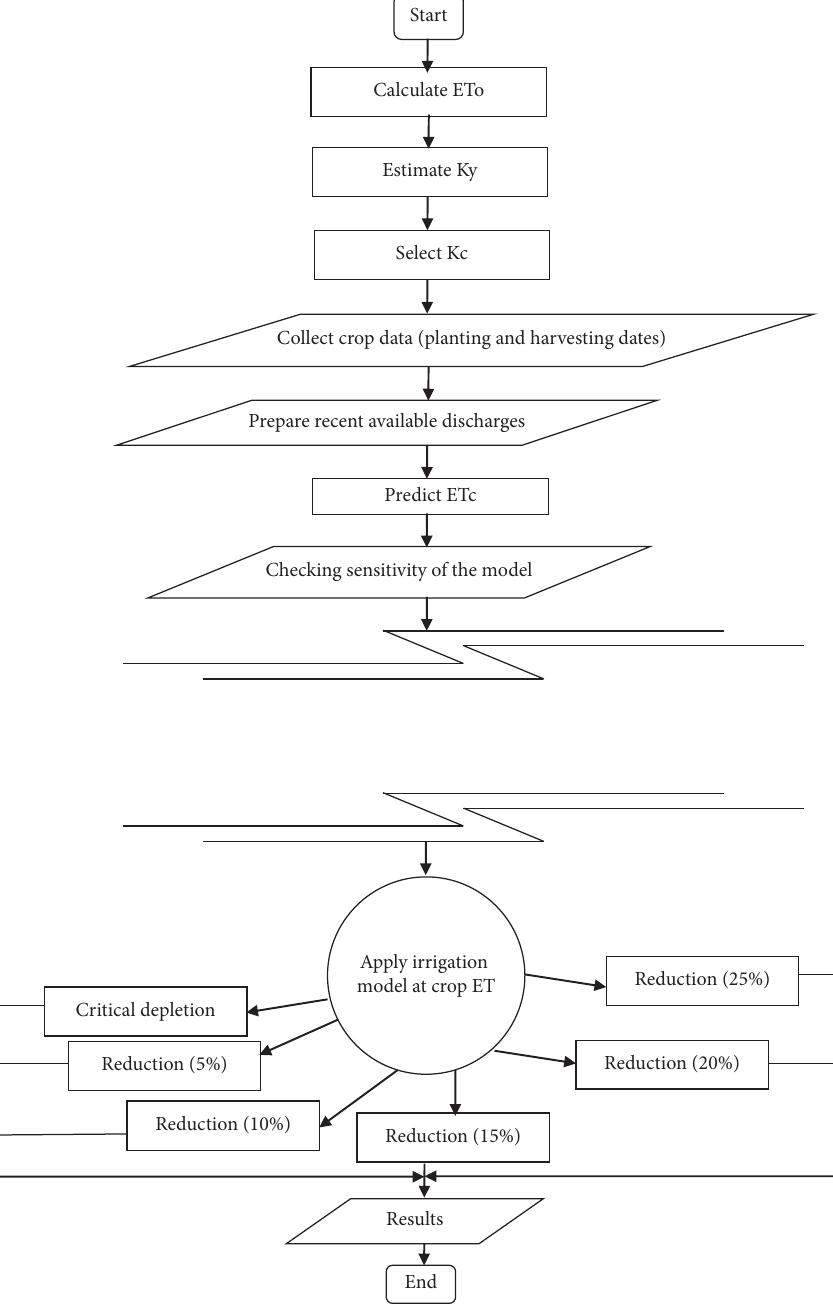
Figure 2: Flow chart of methodology for each